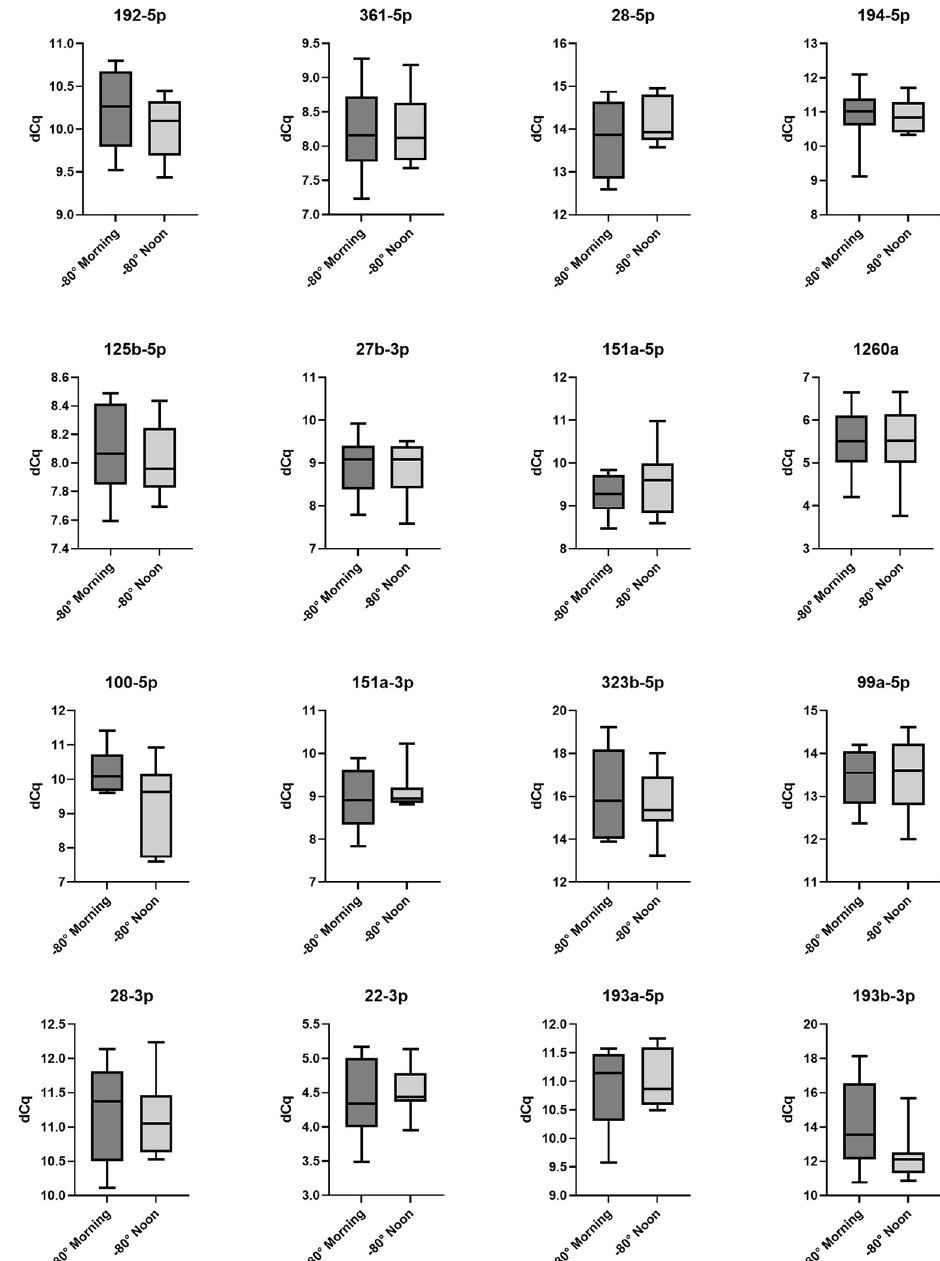
Fig 2. -80˚C morning versus -80˚C noon. Box plots of dCq values of serum MiRNA samples (n = 8) taken in the morning under fasting condition compared to samples (n = 8) taken at noon after normal eating and drinking. All samples were stored 14 days by -80˚C and then analyzed. The differences in the expression were not significant.